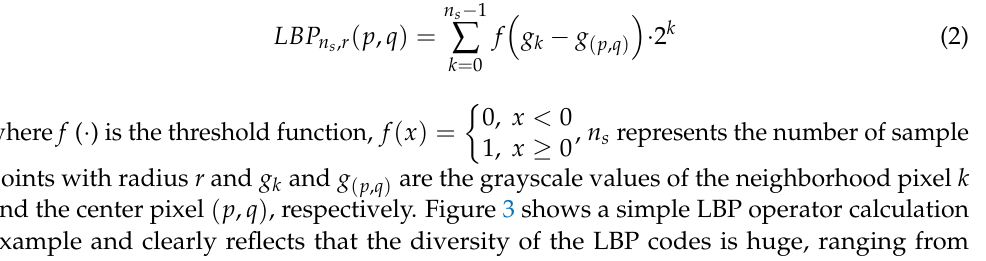
Figure 2. Examples of Shannon entropy of simulated data. ( a , b ) have different composition, but the same spatial distribution; ( b , c ) have the same composition but different spatial distributions.